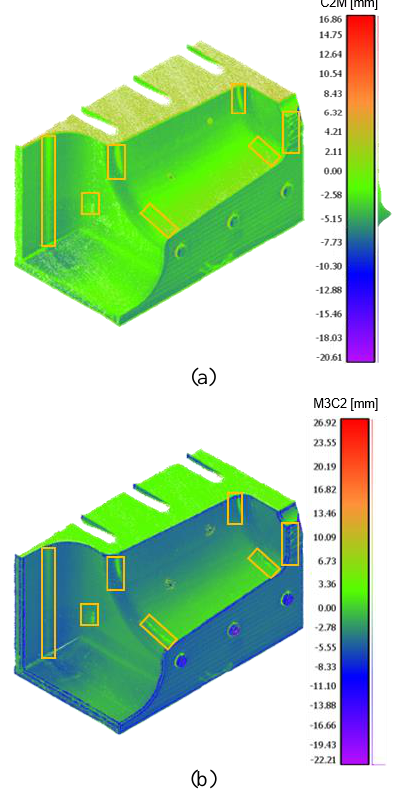
Figure 11 . Deviation distance analysis of the Wax object captured by TLS by utilizing: (a): C2M, and (b):